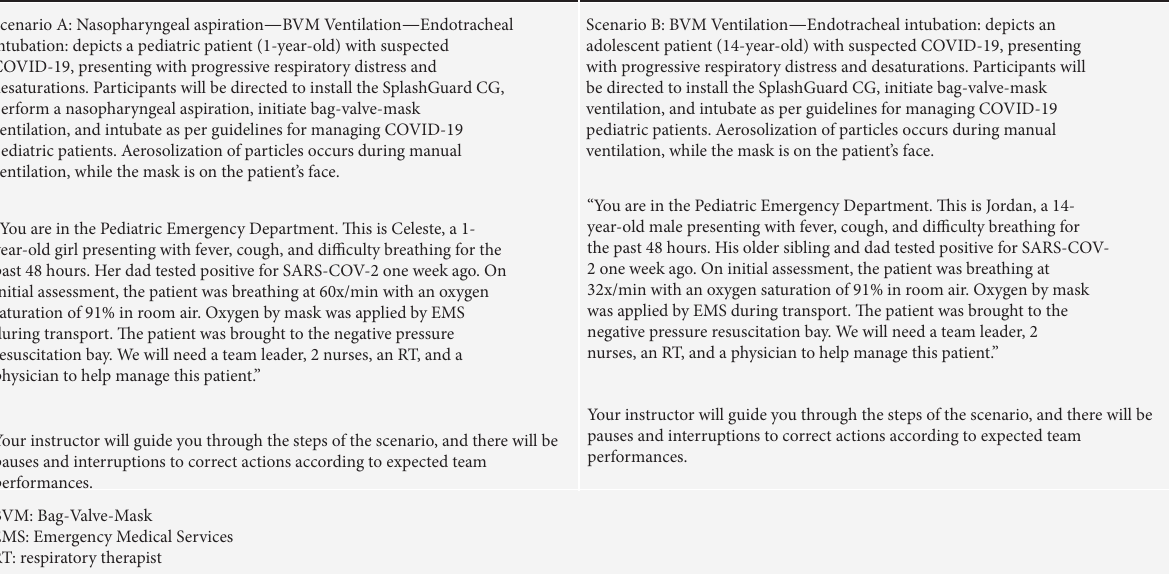
Figure 3: Brief description of the clinical scenarios used during